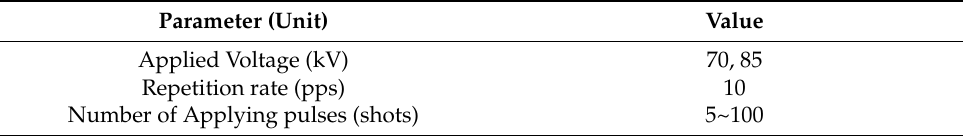
Figure 5. Agar medium configuration (1) and position of E. coli . Table 1. Applied condition of pulsed voltage in plastic petri dish.